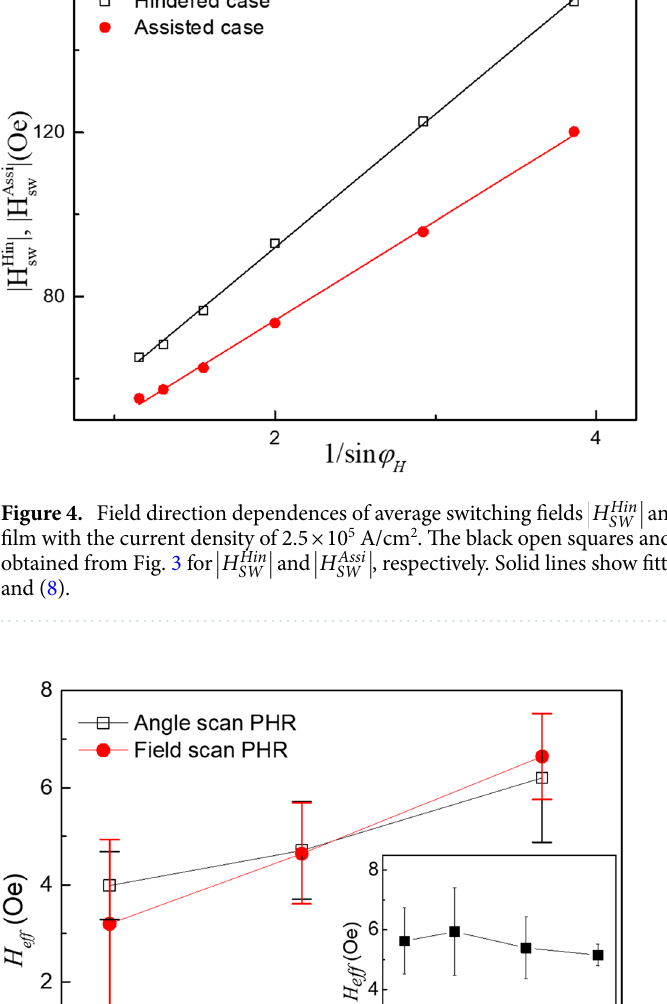
Figure 5. SOI fields obtained from the GaMnAs film for three different current densities. The red solid circles are obtained by analyzing the field scan PHR measurement at several different directions, as discussed in this paper. The black open symbols represent the SOI fields obtained by using methods developed in Ref 24 . Both methods provide consistent results, showing that the SOI field increases monotonically with increasing current density. Inset shows SOI fields obtained at four different temperatures for the current density of J = 2.7 × 10 5 A/ cm 2